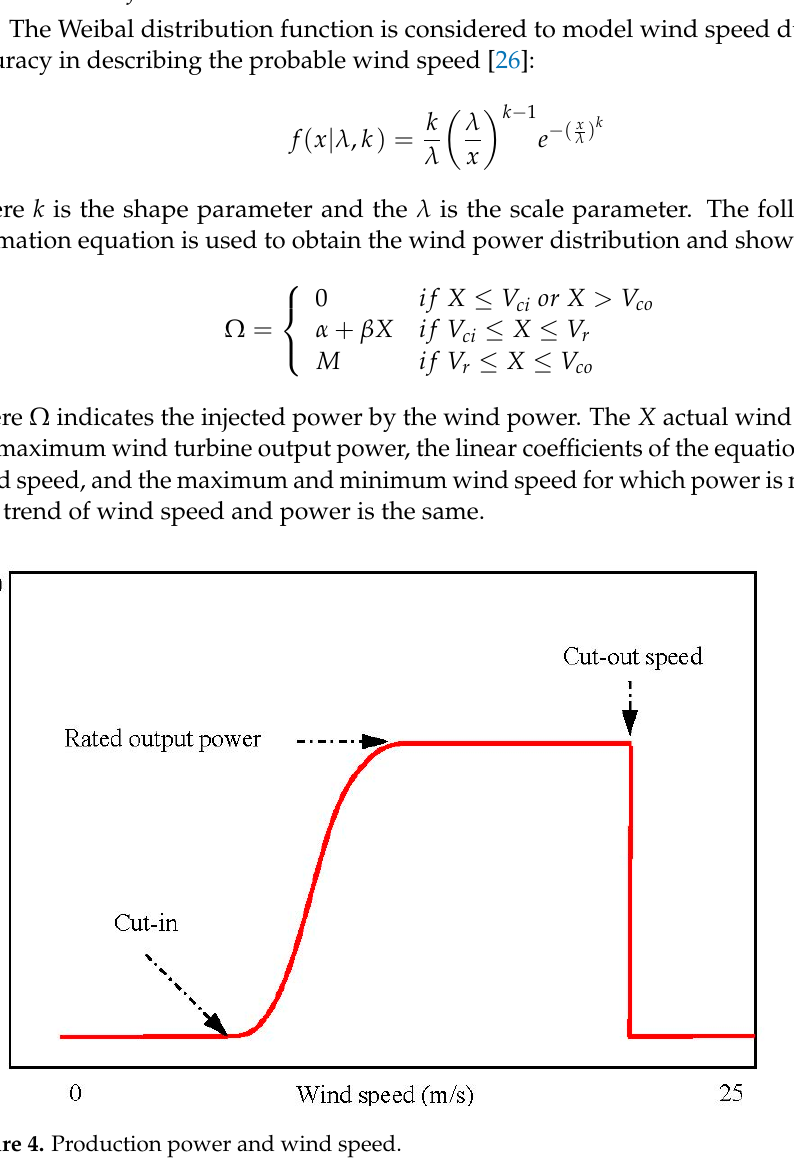
Figure 4. Production power and wind speed.